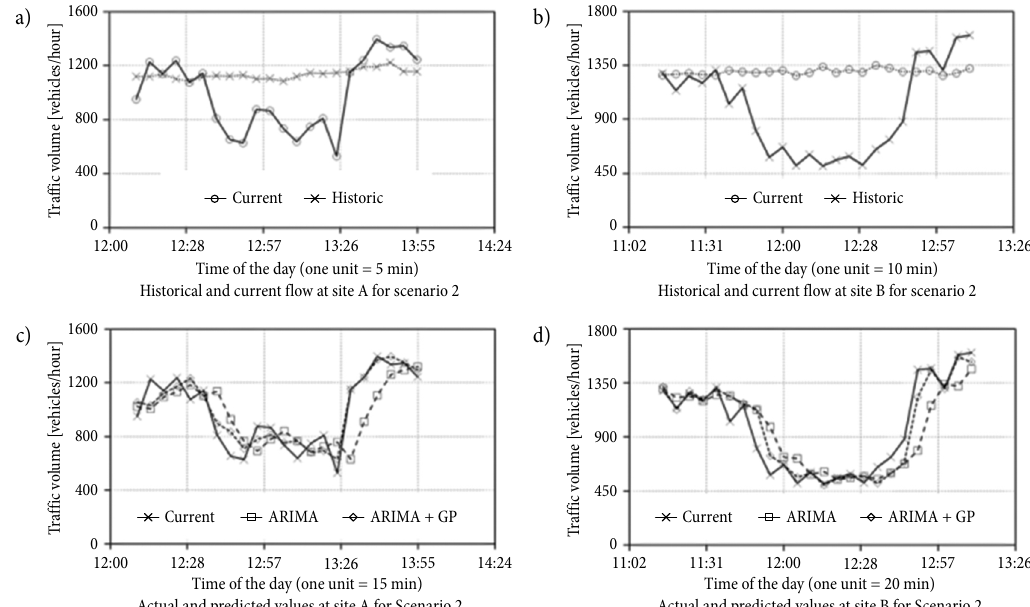
Actual and predicted values at site B for Scenario 2